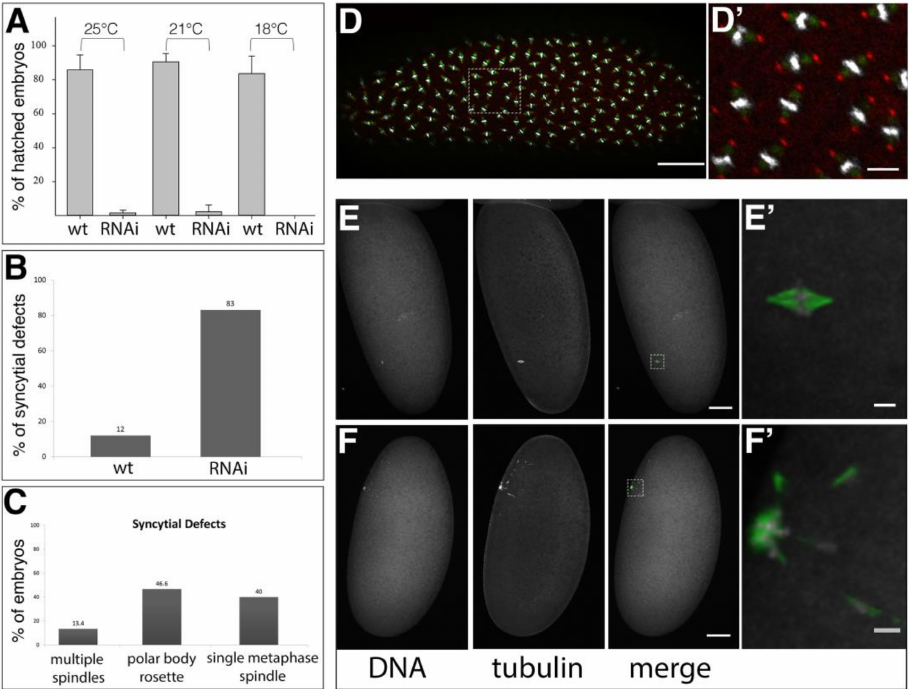
Figure 2. Phenotype of mat-tub >> Gal4 driven Spindly knock-down. ( A ) Larval hatching rates of spindly [ mat67 >>RNAi] embryos at temperatures indicated ( n = 100); for protein levels see Supplementary Materials Figure S1; ( B ) Penetrance of mitotic arrest during syncytial divisions in spindly mat67 >>RNAi embryos ( n = 100). ( C ) Expressivity of syncytial cleavage defects in spindly mat67 >>RNAi embryos ( n = 30); ( D , D’ ) Mitotic domains in wild-type syncytial blastoderm embryo . Nuclei are stained with DAPI (grey), anti-beta-tubulin (green) and anti-Centrosomin (red). Scale bars represent 50 µ m ( D ) and 10 µ m ( D’ ); ( E , F ) Syncytial division defects in spindly mat67 >>RNAi embryos. The images are maximum-intensity projections of 10 µ m z-stack (at spacing of 1 µ m); ( E , E’ ) Embryos often contained a single metaphase-arrested nucleus; ( F , F’ ) In some cases condensed polar body rosettes were visible. (DAPI (grey) and beta-tubulin (green). Scale bars: 50 µ m ( E , F ) and 5 µ m ( E’ , F’